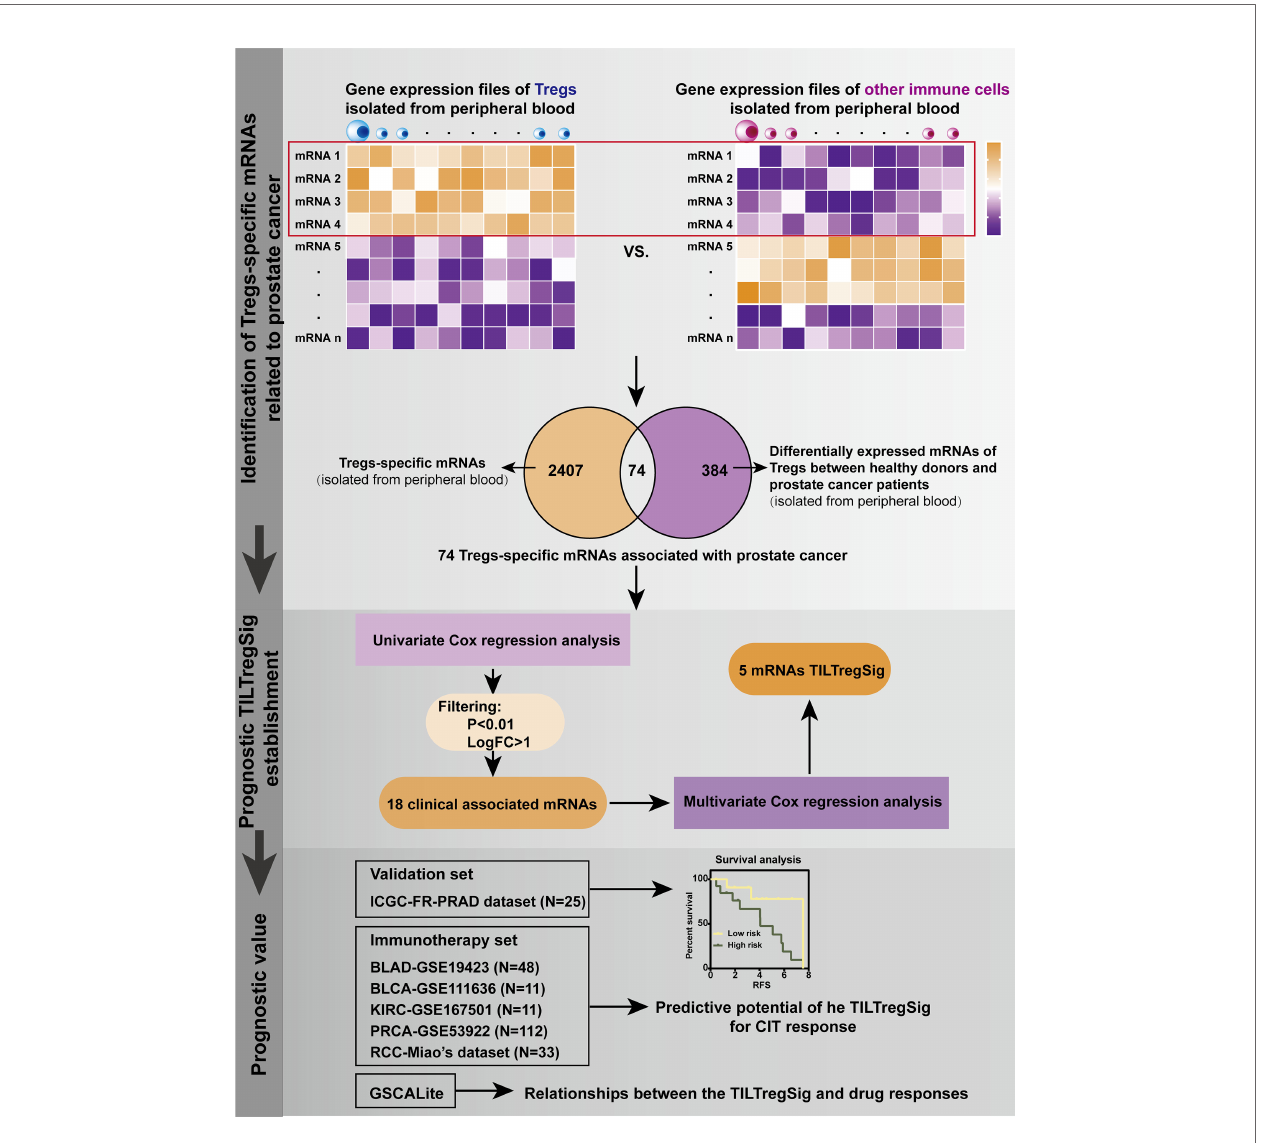
FIGURE 1 | Schematic diagram of the framework for identi fi cation of